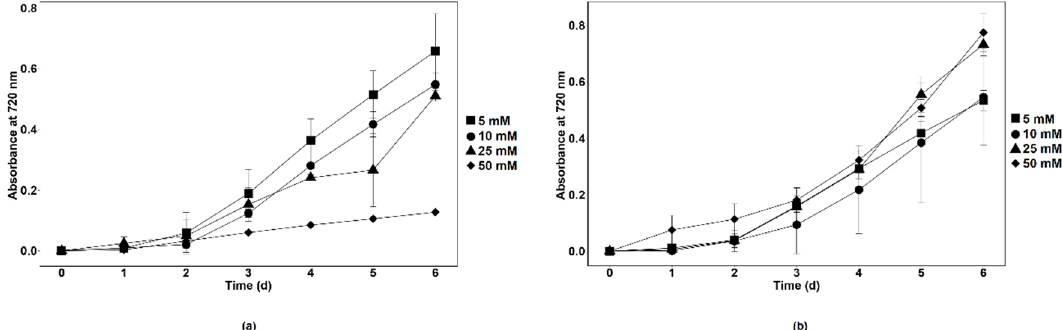
Figure 9. Growth of Chlamydomonas sp. MACC-216 ( a ) and Chlorella sp. MACC-360 ( b ) in SWW supplemented with 5 mM, 10 mM, 25 mM and 50 mM nitrate. Error bars represent standard deviations.